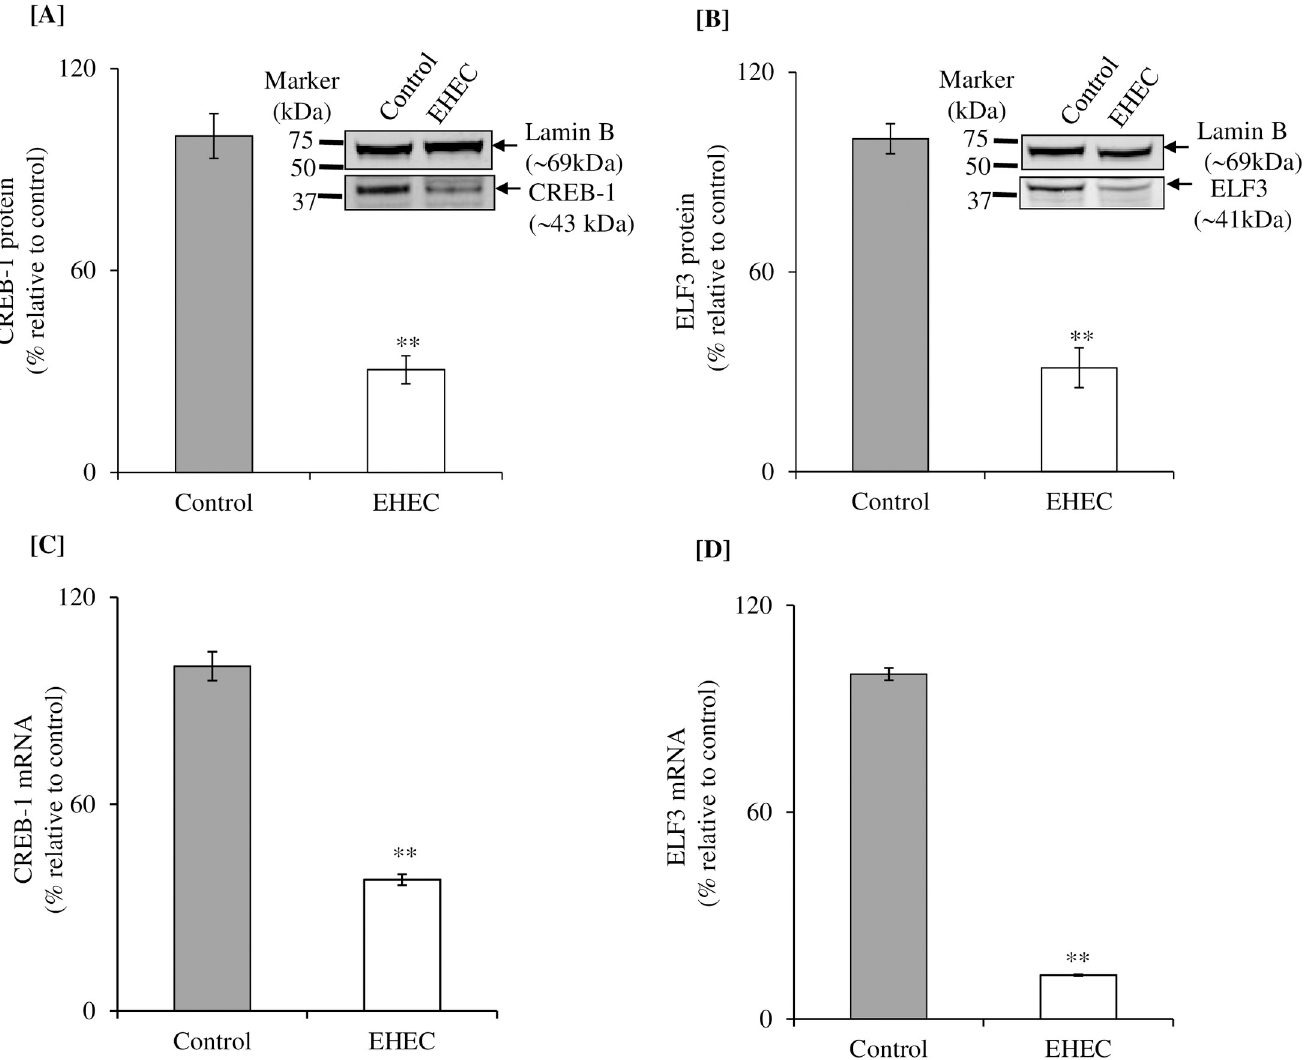
Fig 4. Effect of EHEC infection of NCM460 cells on level of expression of CREB-1 and ELF3 proteins and mRNAs. Levels of CREB-1 [A] and ELF3 [B] proteins expression were determined in NCM460 cells infected with EHEC (200 MOI for 5 h) by western blotting. Normalization of both the proteins expression was done relative to Lamin B. Levels of CREB-1 [C] and ELF3 [D] mRNA expression was determined in NCM460 cells infected with EHEC by RT-qPCR. Normalization of both the mRNAs expression was done by β -actin. Data are mean ± SE of 3 sets of independent experiments. �� P < 0.01.